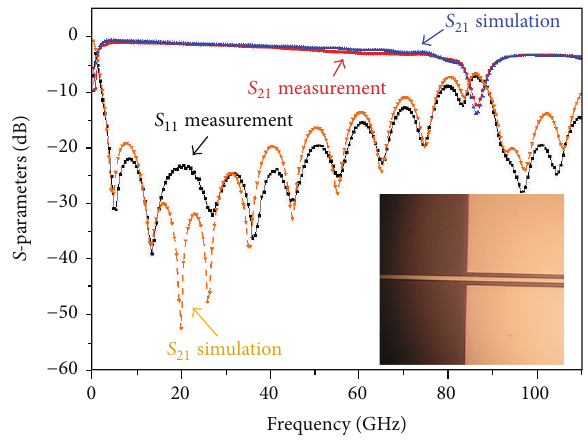
Figure8:Measuredandsimulated 𝑆 -parametersofvia-freeback-to- back GCPW-MS-GCPW transition realized on 20 𝜇 m BCB polymer substrate for 𝑊 = 54 𝜇 m, 𝐺 = 25 𝜇 m, 𝑆 = 1 mm, 𝐿 1 = 1mm, 𝐿 = 1cm, and 2 𝜇 m thick copper metallization.